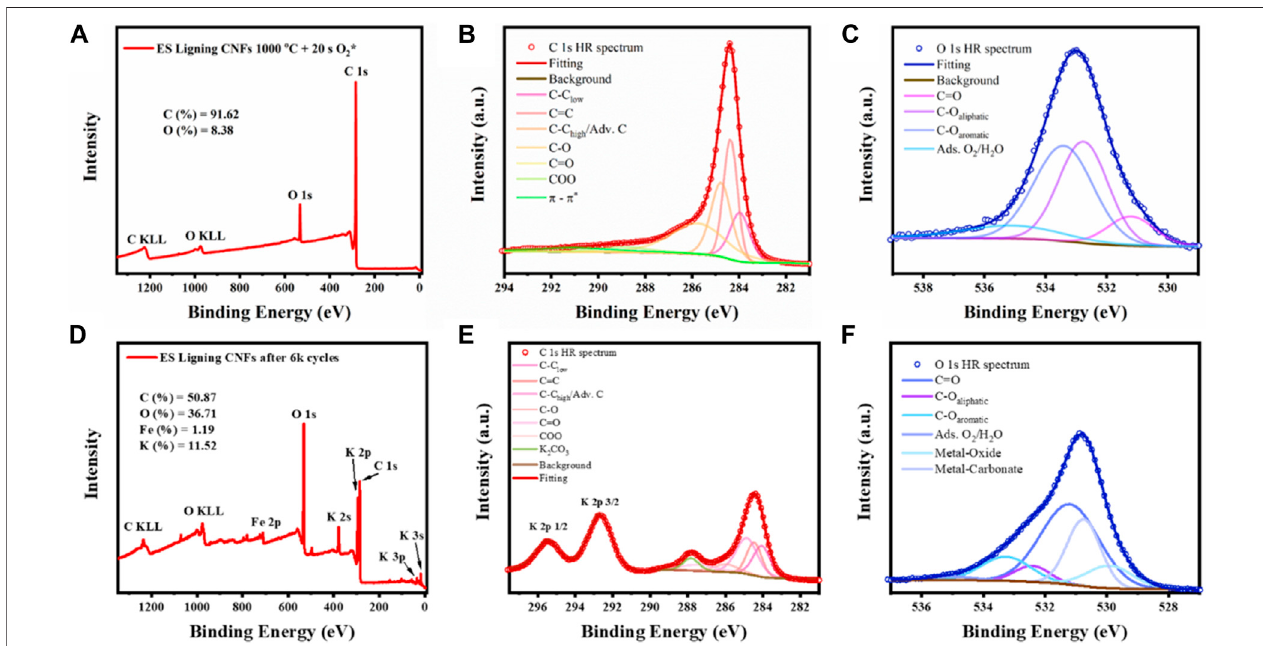
FIGURE 5 | XPS surface analysis on electrospun lignin fi bers treated with O 2 plasma before electrochemical testing: (A) Survey spectrum, (B) C 1s high resolution spectrum peak fi tting, (C) O 1s high resolution spectrum peak fi tting; and surface analysis of the same sample after 6,000 cycles: (D) Survey spectrum, (E) C 1s high resolution spectrum peak fi tting, (F) O 1s high resolution spectrum peak fi